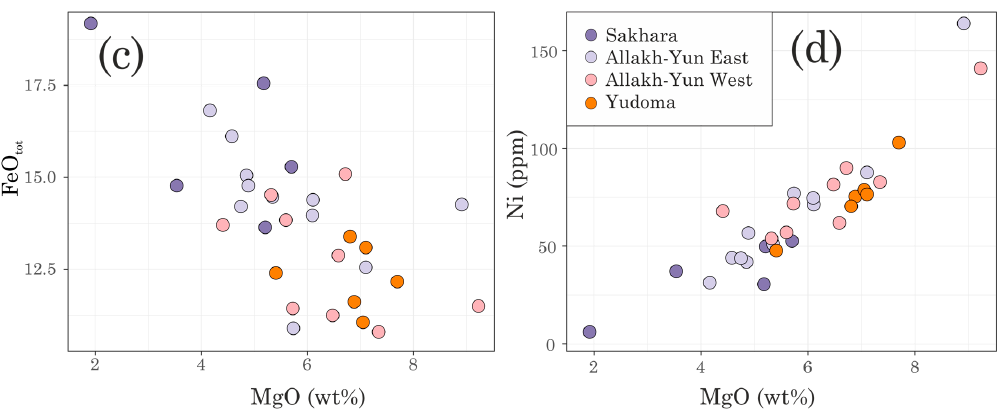
Figure 5. Plots of ( a ) CaO (wt%), ( b ) TiO 2 (wt%), ( c ) FeO tot (wt%), and ( d ) Ni (ppm) vs. MgO (wt%) for